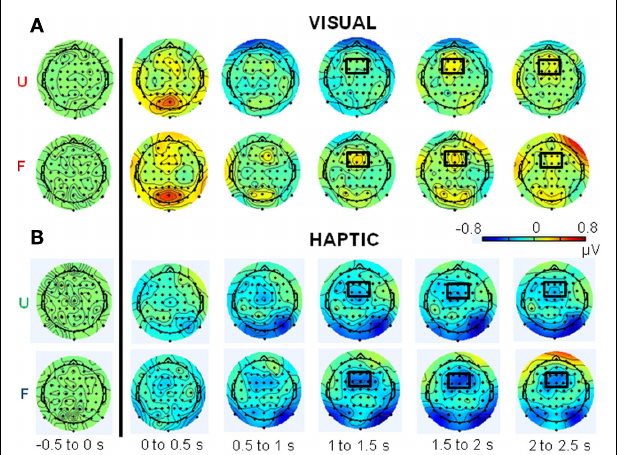
FIGURE 5 |Topographical plots of total theta-band (5–7Hz) activity for the (A) visual and (B) haptic object recognition tasks. Plots are displayed in 500ms time segments, from − 500 to 2500ms, with the black line indicating stimulus onset. “U” stands for unfamiliar and “F” for familiar objects. Note: same scale for vision and haptics.